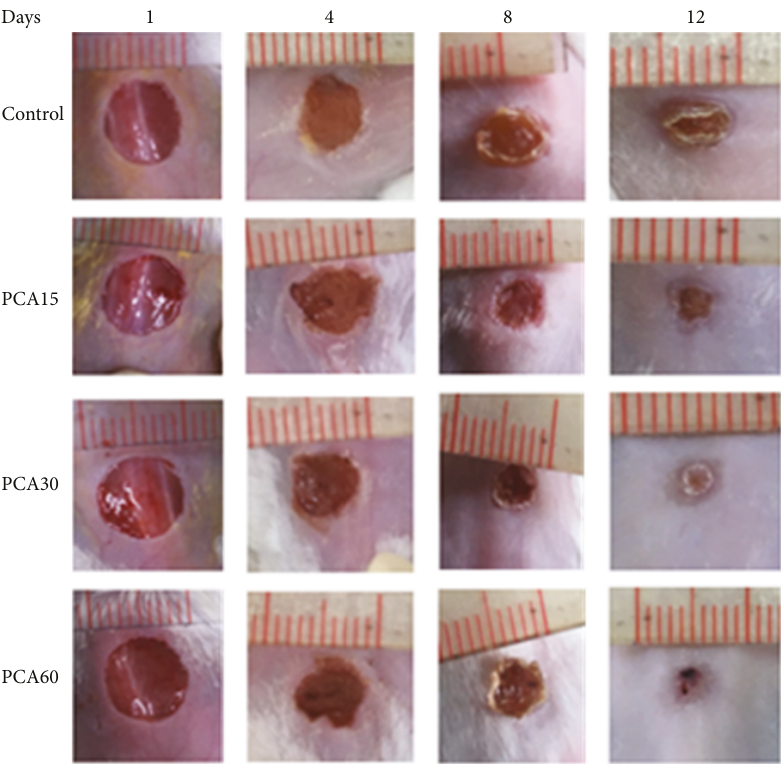
Figure 5: Representation images of the implanted area from day 1 to day 12.